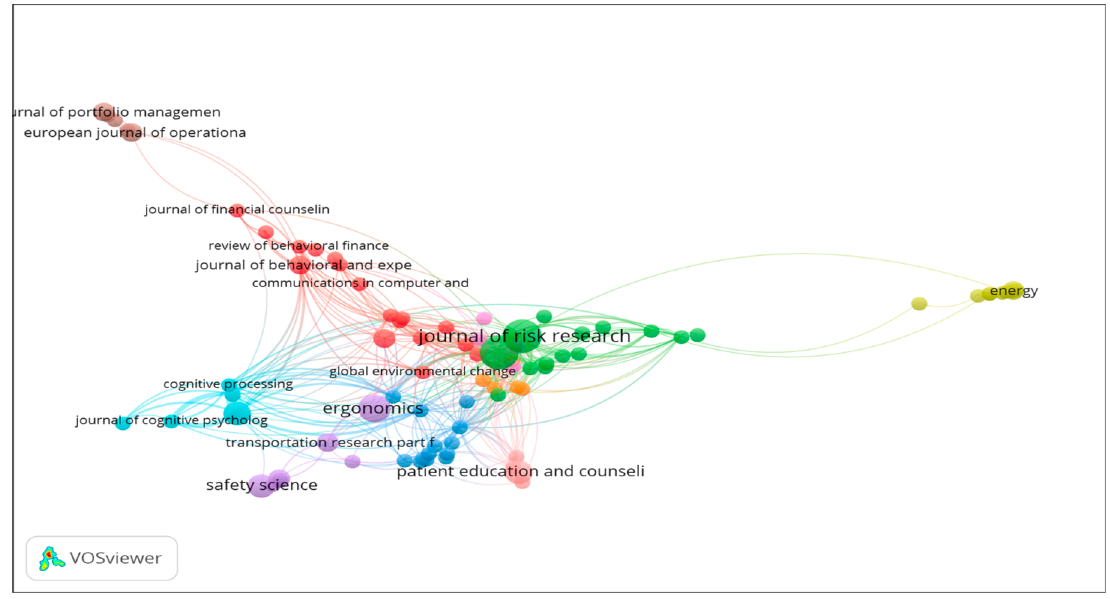
Figure 2. Visualisation map of Top 20 Sources of Most Cited Documents on “Objective Risk” and “Subjective Risk”.